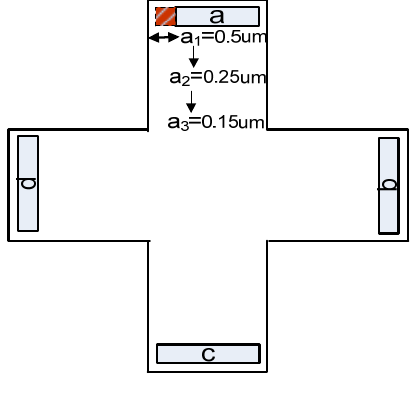
Figure 25. The induced asymmetry on the biasing contact a for cross-like Hall